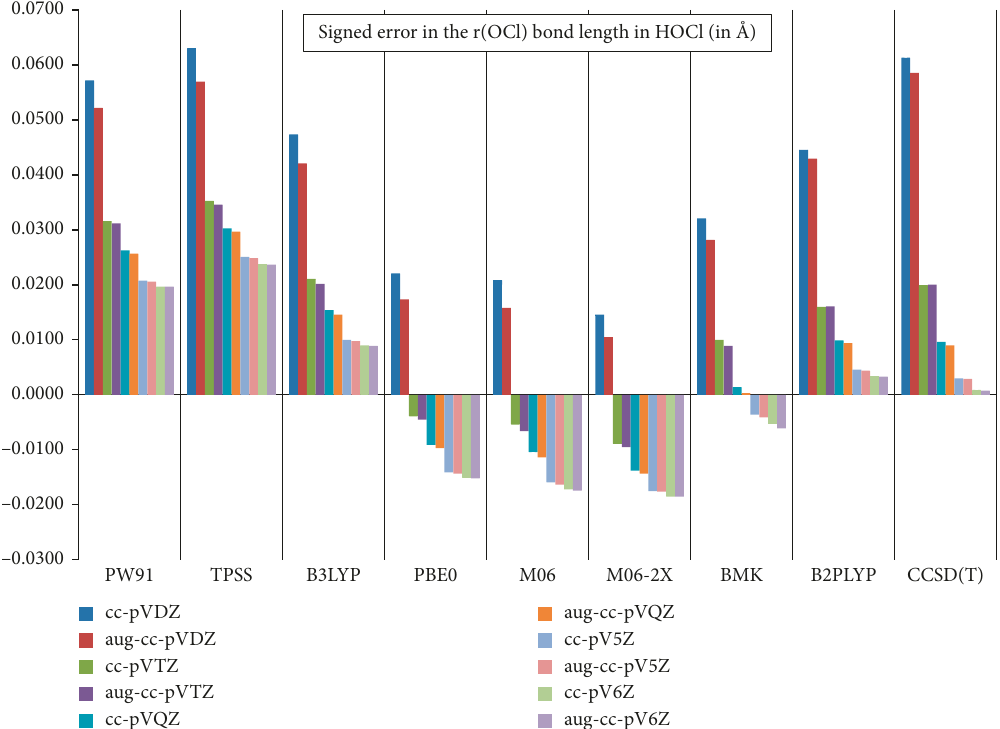
Figure 4: Signed error of the calculated r (OCl) bond distance with respect to the experimental one determined by Deely (see text (in